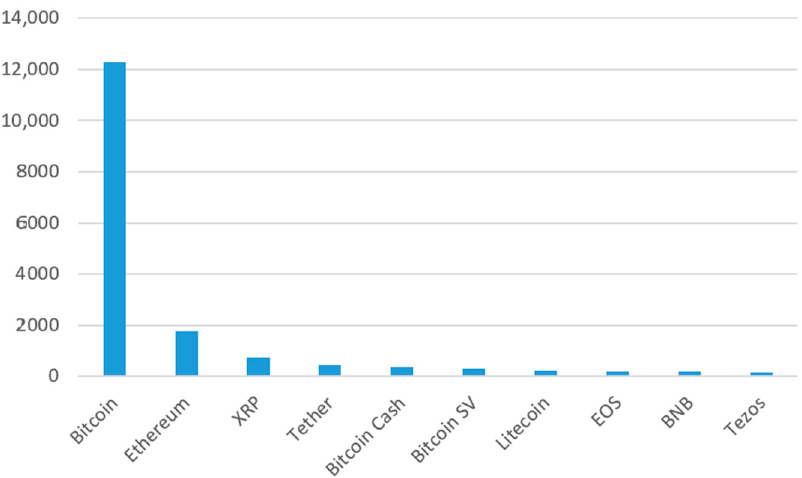
Figure 8. Cryptocurrency capitalization, billion rubles. Source: https://ru.tradingview.com.